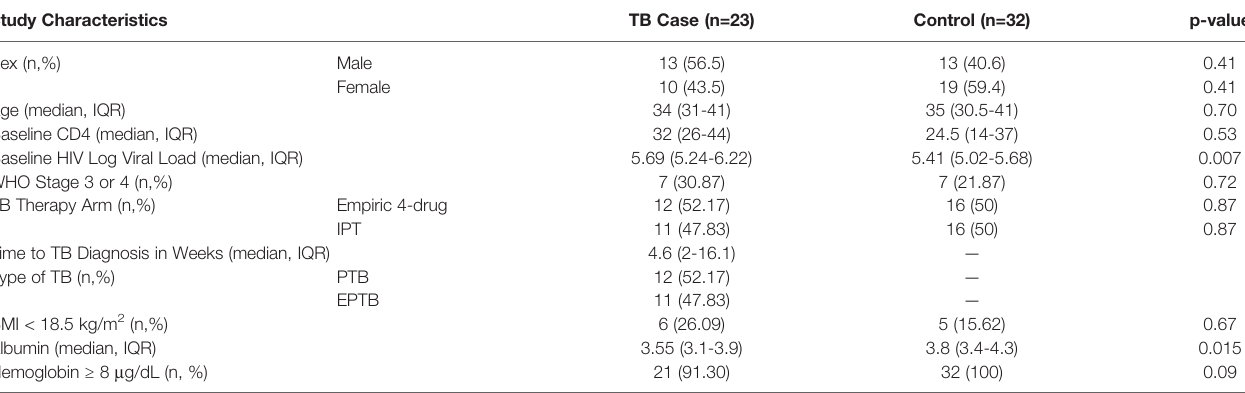
TABLE 1 | Characteristics of cases and